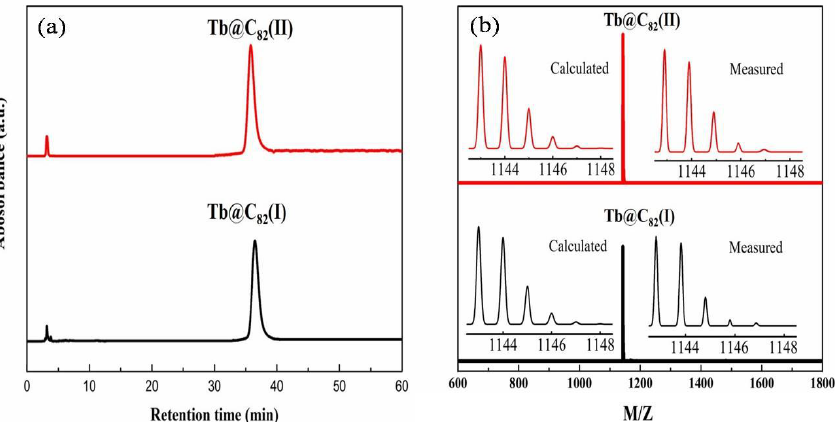
Figure 2. ( a ) Analytical liquid chromatography chromatograms on a Buckyprep column (Φ = 4.6 × 250 mm, 1 mL/min in toluene flow) and ( b ) MALDI-TOF mass spectra of Tb@C 82 (I, II) isomers.